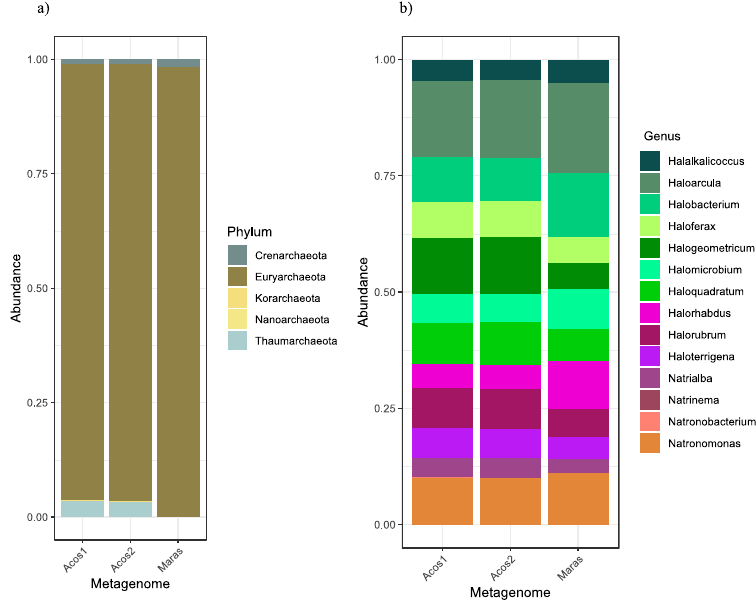
Figure 3. Taxonomic classification of archaea according to MetaGenome Rapid Annotation Subsystems Technology (MG-RAST). ( a ) Composition of the archaeal community at the phylum level, where Euryarchaeota prevail. ( b ) Diversity within the class Halobacteria. The genus Haloarcula prevails in all samples.